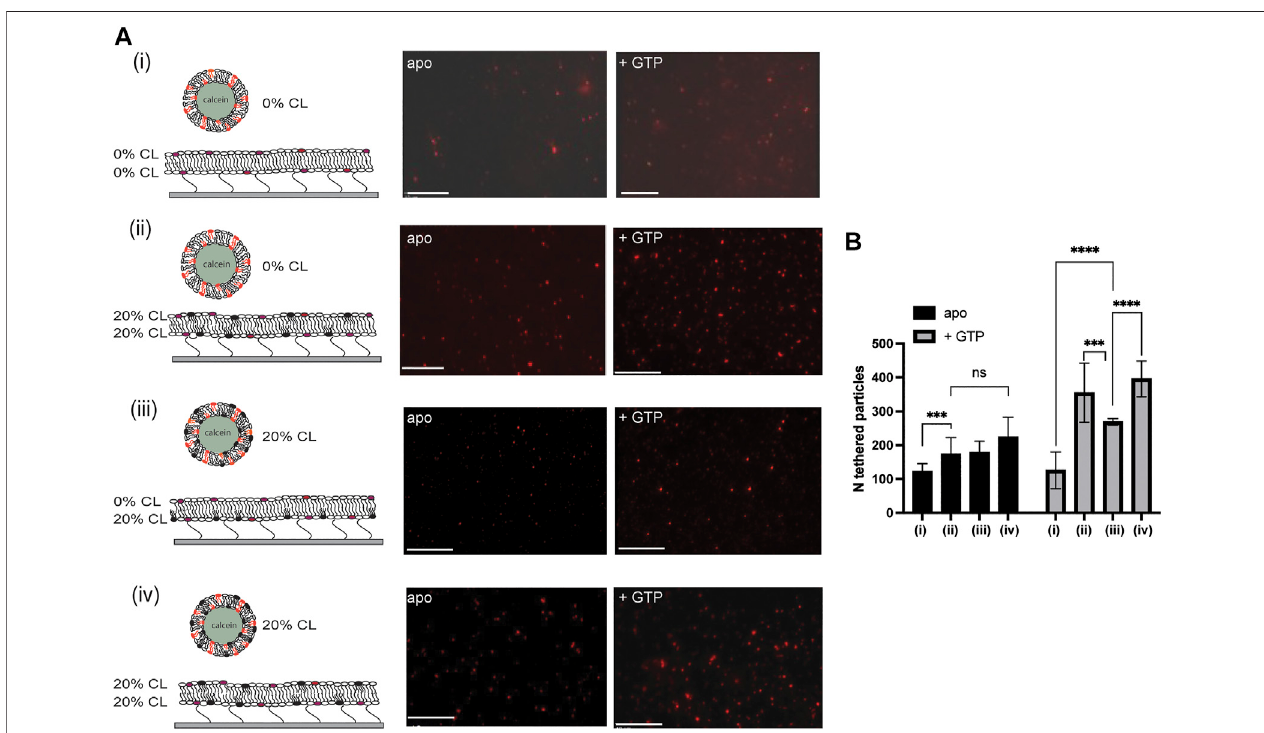
FIGURE 2 | Effect of cardiolipin distribution and membrane asymmetry on l-Opa1 mediated membrane tethering. We compared four conditions: no CL in the bilayer or proteoliposomes ( Figure 2Ai );20% (mol) CL symmetrically distributed in both lea fl ets ofthe supported bilayer,no CL in liposomes( Figure 2A ii); no CL inonly the top lea fl et of the bilayer, proteoliposomes with symmetric 20% CL ( Figure 2A iii); 20% CL liposomes and bilayers, symmetrically distributed in both lea fl ets ( Figure 2A iv). Scale bar: 10 µm. Data were collected from three to fi ve independent experiments at 5 – 10 random positions. Statistical analyses were performed using a t -test. The illustrations indicate lipid distribution in the membrane, with both bilayers containing reconstituted l-Opa1.